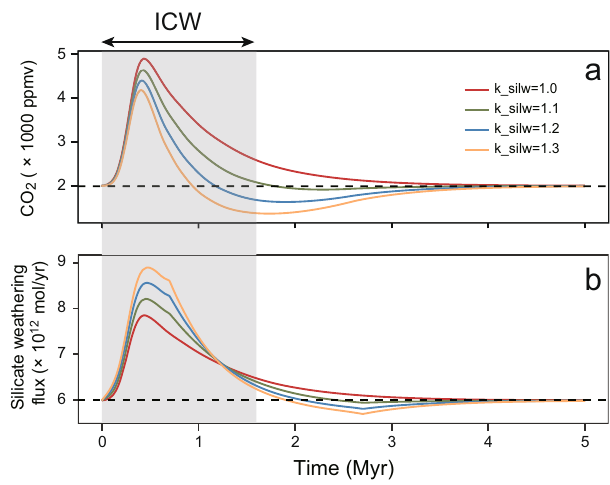
Fig. 5 Model results of LOSCAR for the T – J boundary carbon-cycle perturbation. The weatherability (k_silw) factors were setted to 1.0, 1.1, 1.2, and 1.3. a Atmospheric p CO 2 level. b Silicate weathering fl ux. The gray shaded rectangle represents the interval of intense chemical weathering (ICW), yielding elevated silicate weathering fl uxes. The horizontal dashed lines represent the background values of atmospheric p CO 2 ( a ) and silicate weathering fl ux ( b ) before the CAMP